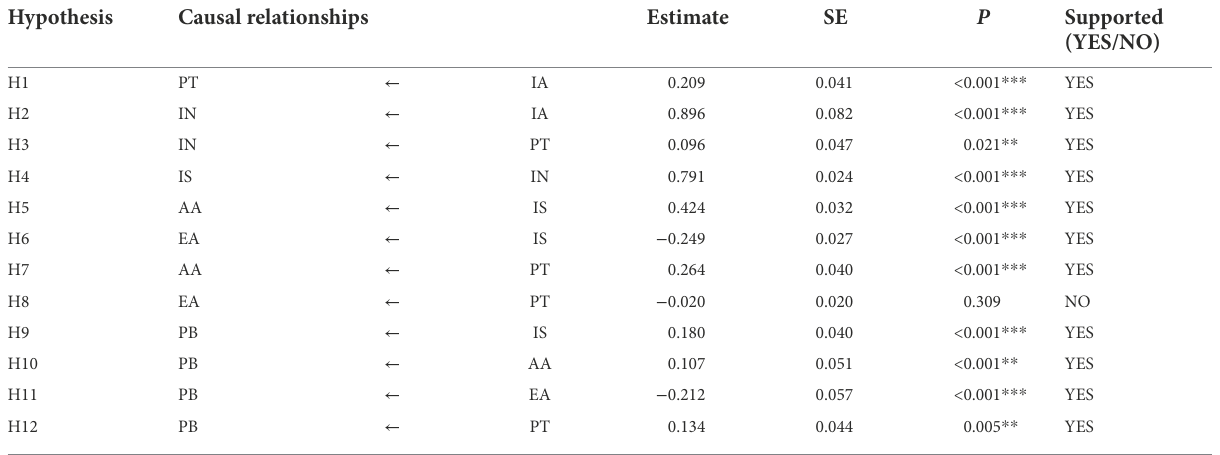
TABLE 6 Results of structural equation